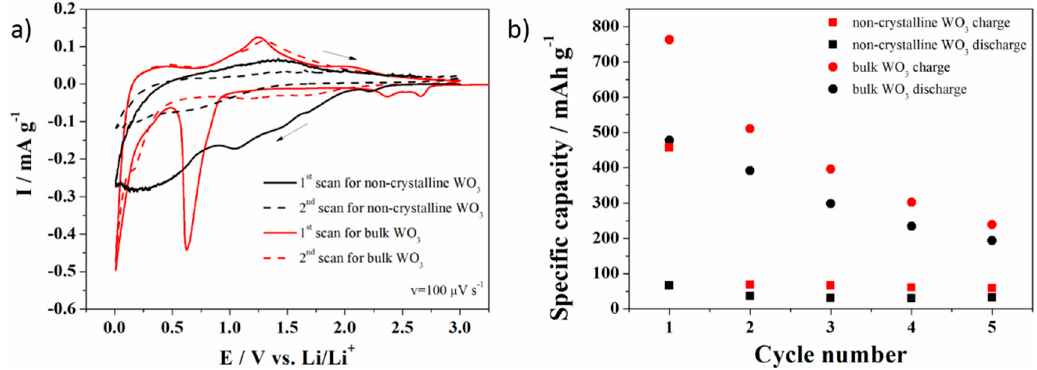
Figure 10. Electrochemical performance of the bulk and hydrated and non-crystalline WO 3 electrode material in 1 M LiPF 6 in EC/DMC 1:1 ( a ) cyclic voltammetry, ( b ) galvanostatic tests for battery application.